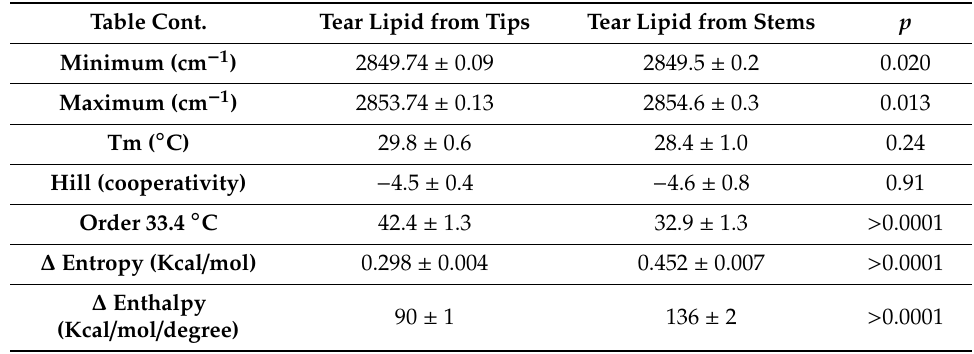
Table 1. Phase transition parameters of tear lipids extracted from the tips and stems of Schirmer’s strips from a 63-year-old male. Table Cont.